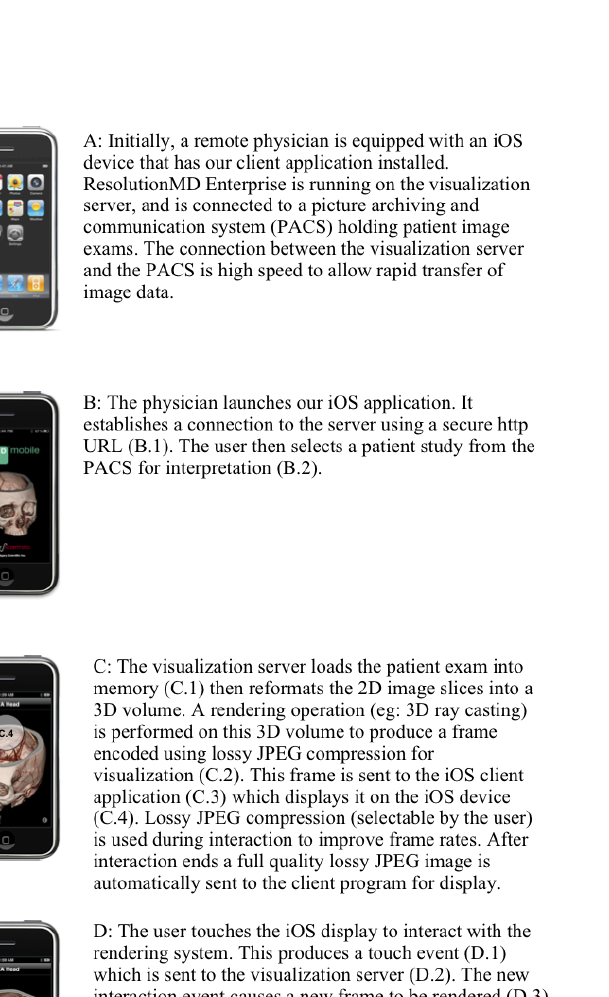
Figure 1. A schematic overview of the client-server teleradiology